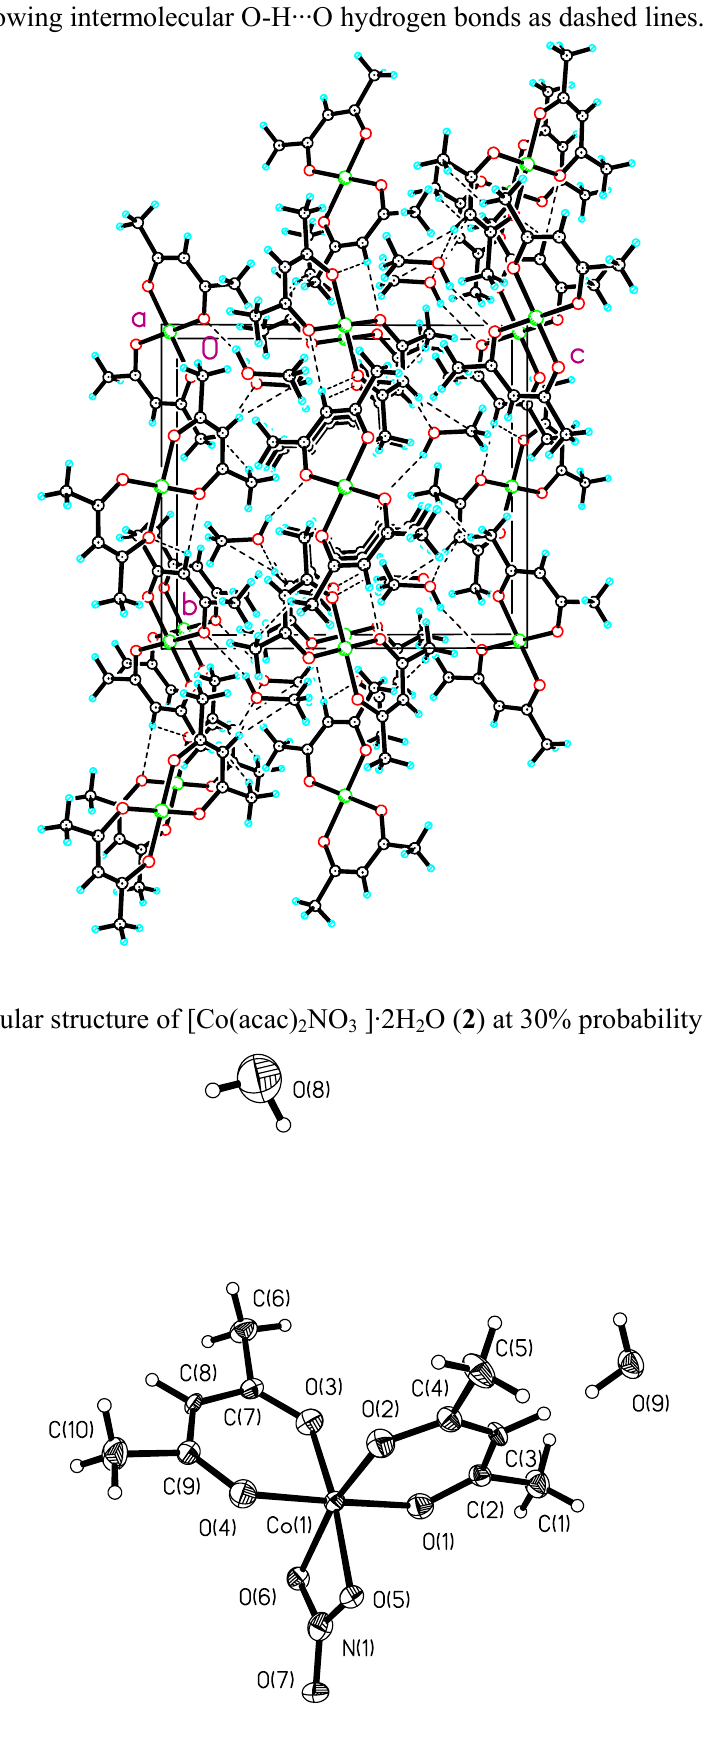
] ·0.5CH OH ( 1 ) viewed along a- axis, 2 2 3